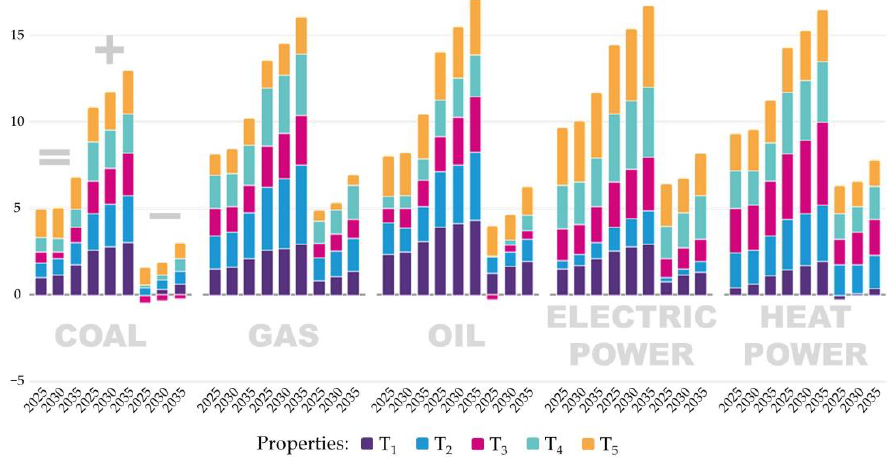
Figure 7. Industry’s scenario coefficients of the development of properties of the North-Western LFEC at three time intervals.